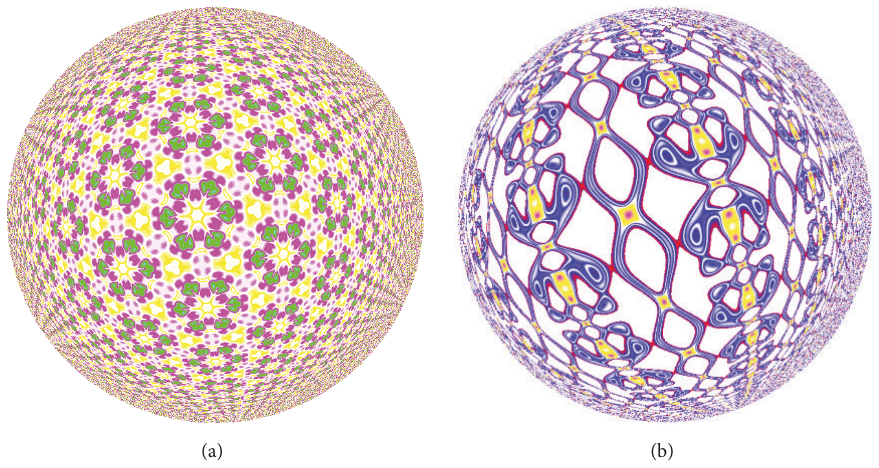
Figure 5: Colorful spherical wallpaper patterns with the 𝑝6𝑚 (a) and 𝑝𝑚𝑚 (b) symmetry.